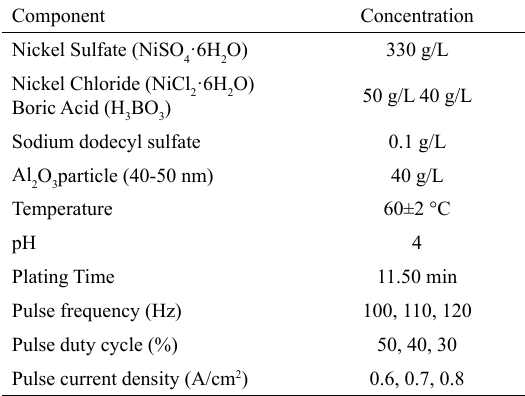
Table 2. Bath compositions and electrodeposition conditions.